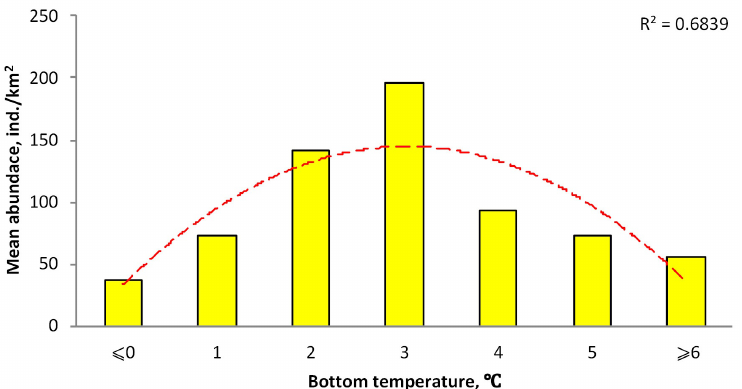
Figure 6. Catch distribution of the Aleutian skate Bathyraja aleutica according to bottom temperature in Alaskan waters: (yellow bar) mean value, (dash line) smoothed trend (R 2 = 0.6839).